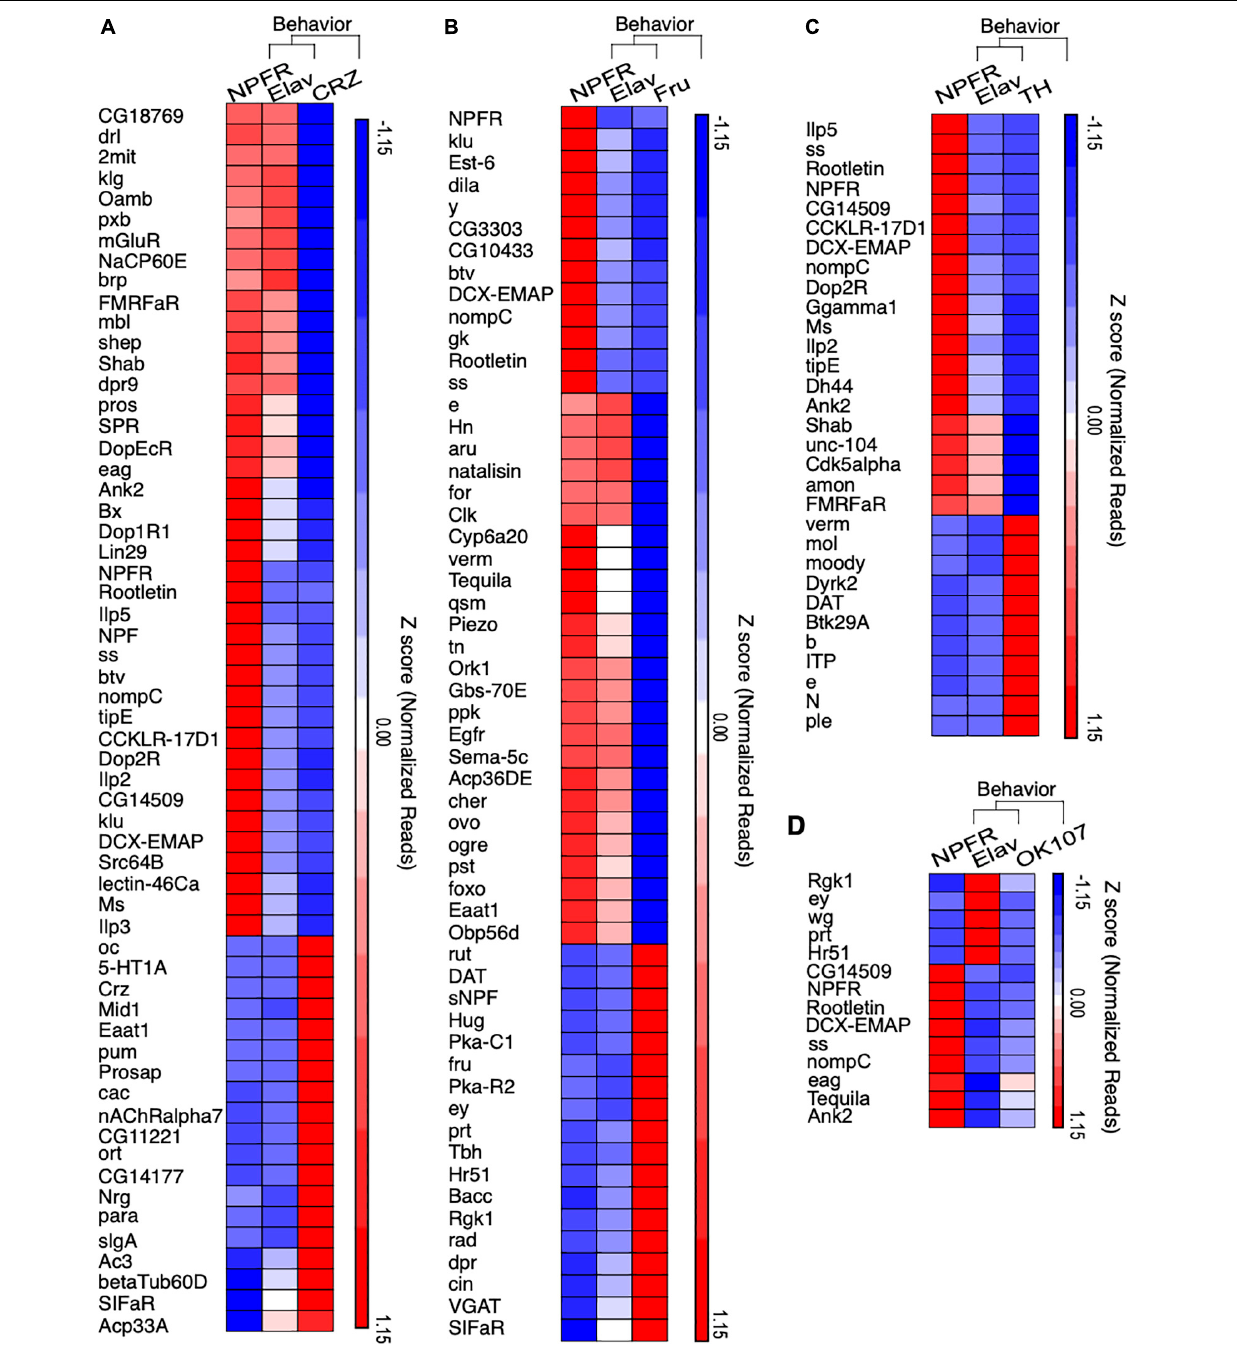
prompted us to test the behavioral significance of reducing RNA editing in CRZ neurons as well. However, knocking down ADAR in CRZ neurons only led to moderate effects on